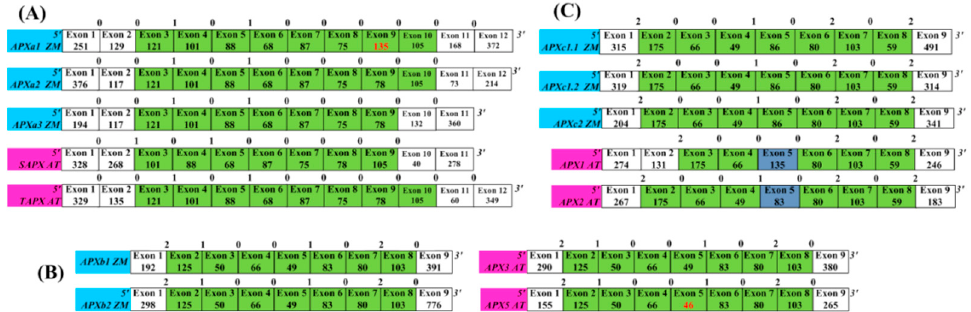
Figure 3. The comparison of exon/intron structures of APX genes in classes A, B, and C. ( A ) Exon/intron structures of APX genes of class A of Z. mays and A. thaliana . ( B ) Exon/intron structures of APX genes of class B of Z. mays and A. thaliana . ( C ) Exon/intron structures of APX genes of class C of Z. mays and A. thaliana . The intron phases are shown on top of each exon boundary. Exon sizes are not drawn to scale. Green columns indicate highly similar exons of the same size among different species. ZM, Zea mays ; AT, Arabidopsis thaliana . The genes from A. thaliana and maize are labeled by pink columns and blue columns respectively.